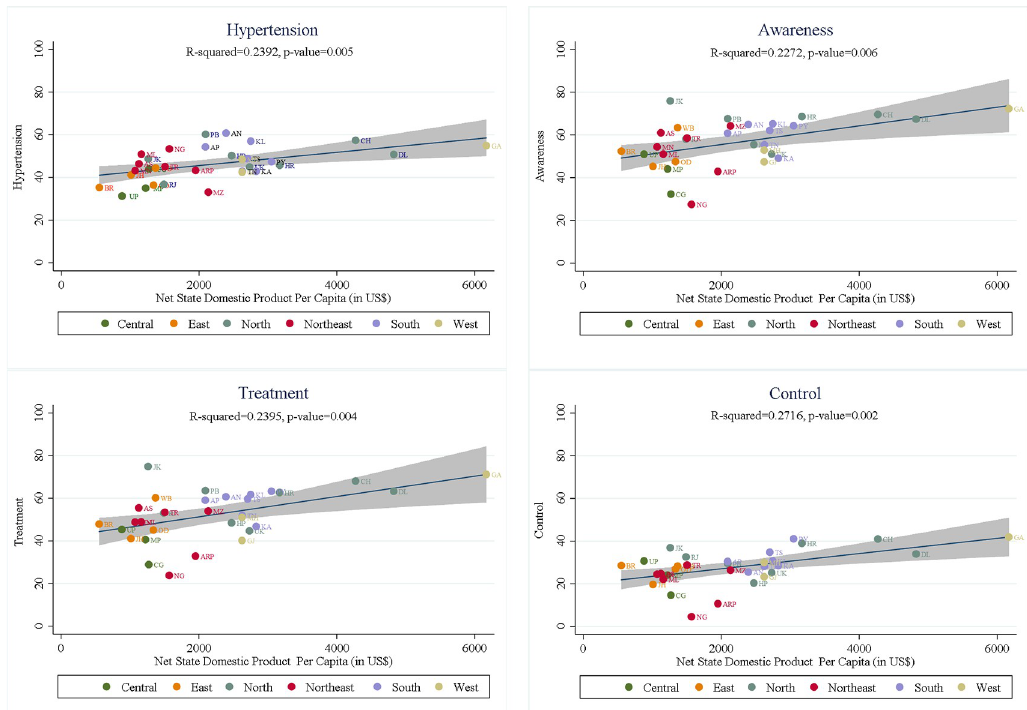
Fig 3. The association of NSDP per capita (in US$) with each of hypertension prevalence and ATC. Note: NSDP per capita for the year survey period (2017–2018) were taken from the Reserve Bank of India website and converted into US$ (1 US$ = ₹ 66.75) (https://rbi.org.in/Scripts/AnnualPublications.aspx%3Fhead%3DHandbook%20of%20Statistics%20on%20Indian% 20States). AN, Andaman and Nicobar Islands; AP, Andhra Pradesh; ARP, Arunachal Pradesh; AS, Assam; ATC, awareness, treatment, and control; BR, Bihar; CG, Chhattisgarh; CH, Chandigarh; DL, Delhi; GA, Goa; GJ, Gujarat; HR, Haryana; HP, Himachal Pradesh; JH, Jharkhand; JK, Jammu and Kashmir; KA, Karnataka; KL, Kerala; MH, Maharashtra; ML, Meghalaya; MN, Manipur; MP, Madhya Pradesh; MZ, Mizoram; NG, Nagaland; NDSP, net state domestic product; OD, Odisha (Orissa); PB, Punjab; PY, Puducherry; RJ, Rajasthan; TN, Tamil Nadu; TR, Tripura; TS, Telangana State; UK, Uttarakhand (Uttaranchal); UP, Uttar Pradesh; WB, West